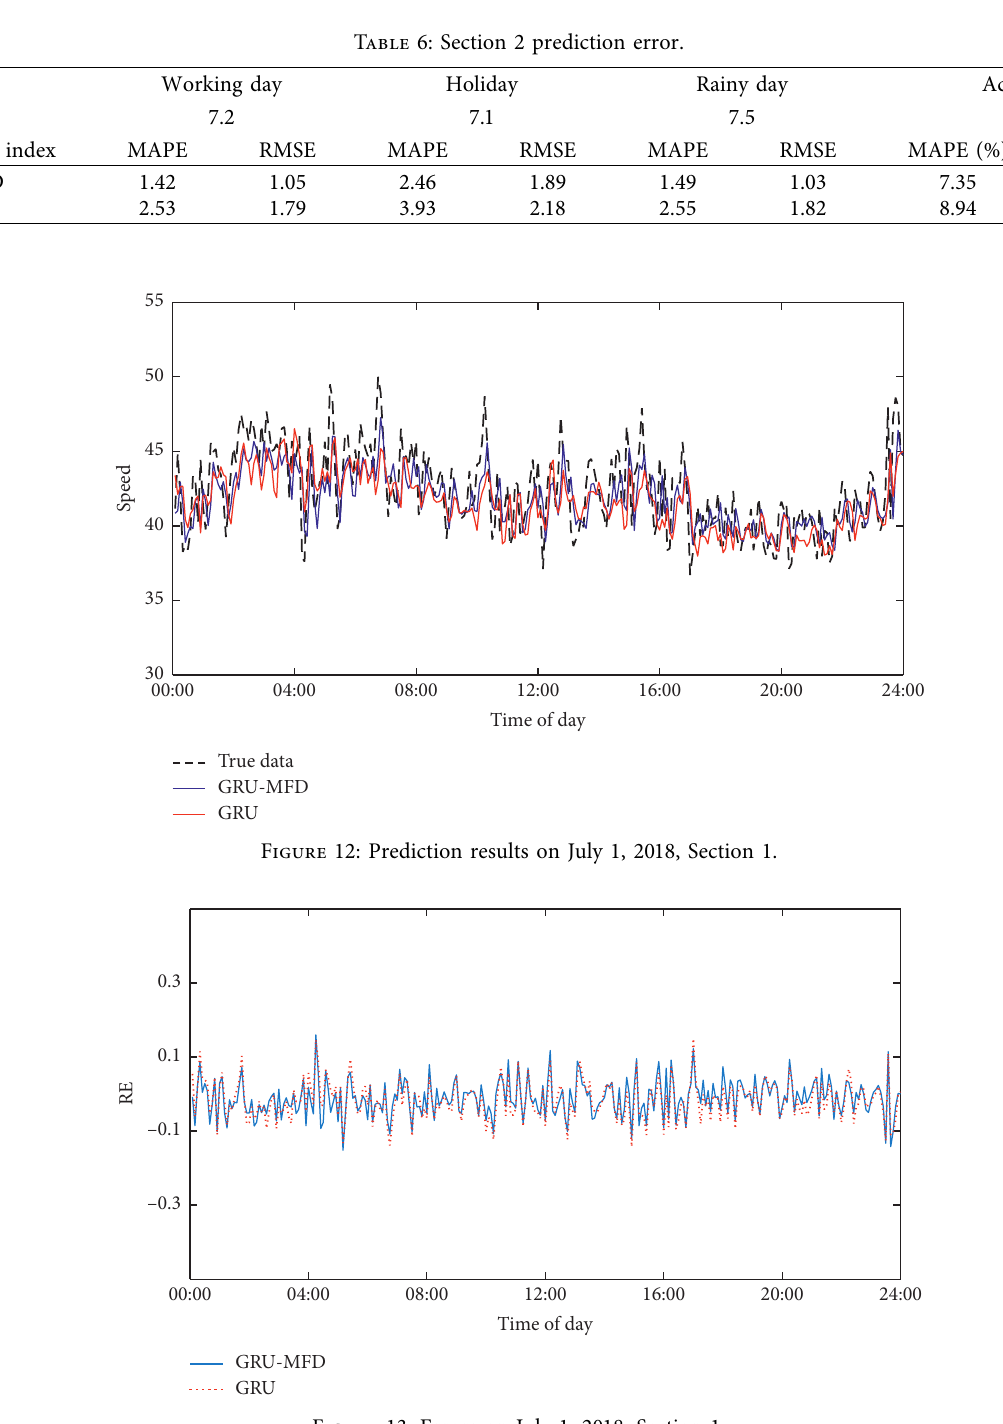
Figure 13: Errors on July 1, 2018, Section 1. Figure 19. The algorithm proposed in this paper can achieve acceptable prediction results. The results of error evaluation indicators MAPE and RMSE are shown in Table 6. MAPE was 1.49% and 2.55%, and the RMSE was 1.03 and 1.82, respectively.